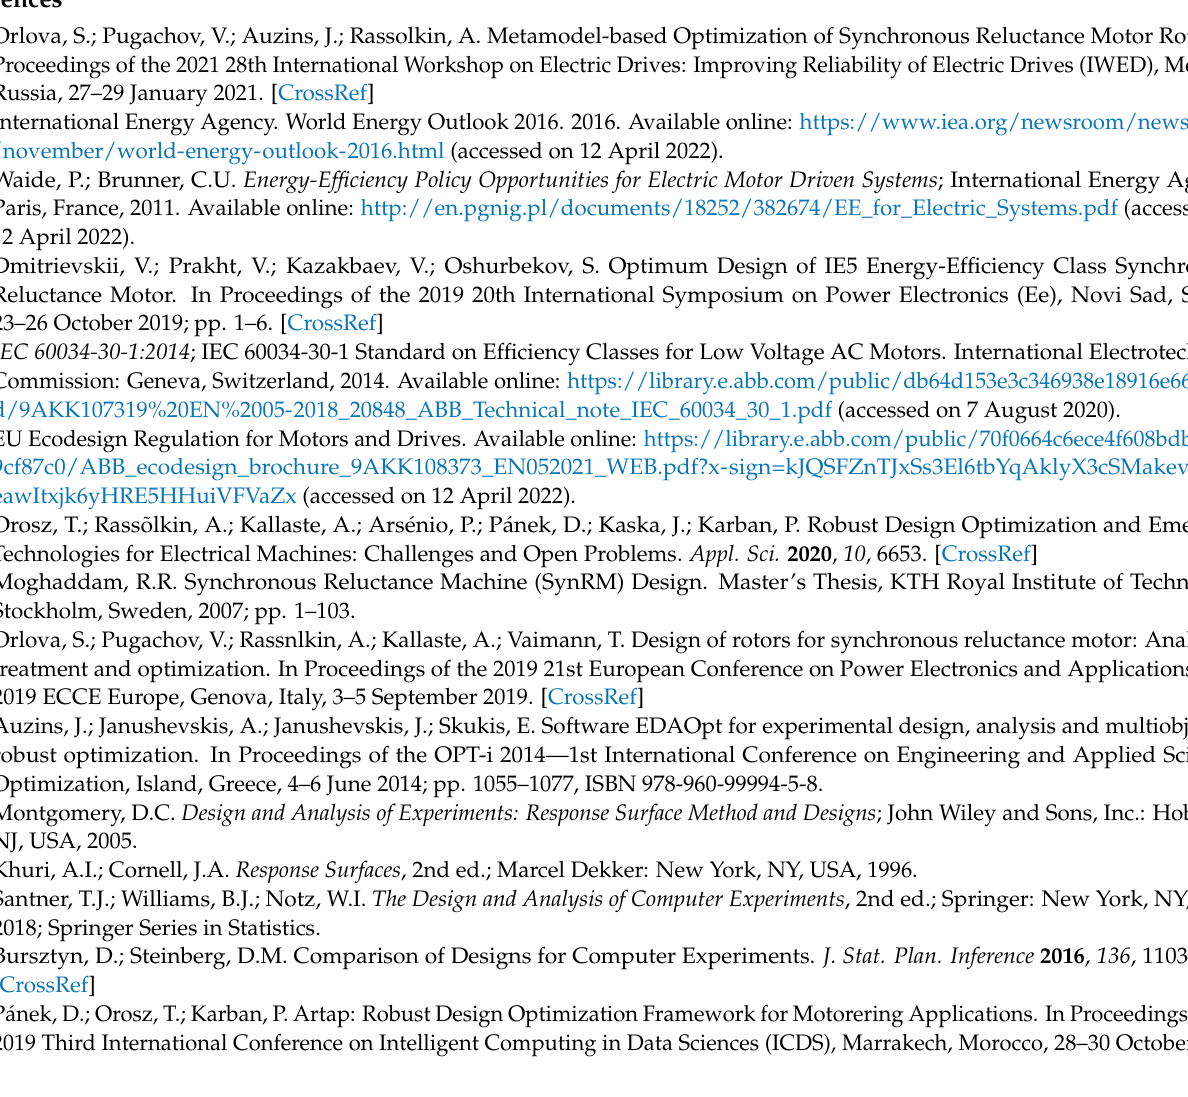
Figure A2. Normal probability plot for y 3 residuals.